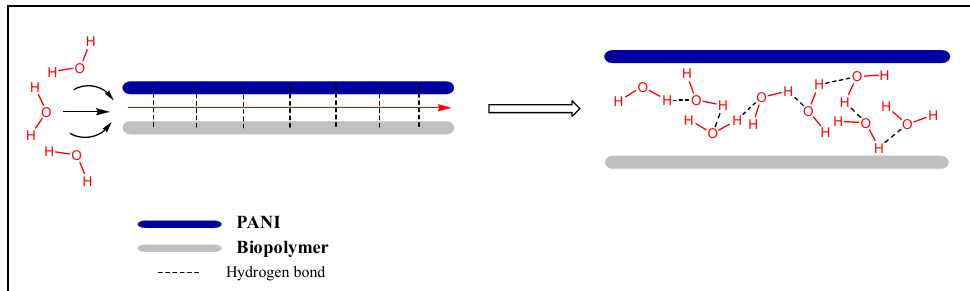
Figure 16. A conceptual structural model of a hydrogen-bonded composite in an anhydrous form (initial state; left ) and accompanying dissociation of the polymer complex (final state; right ) at elevated relative humidity levels.